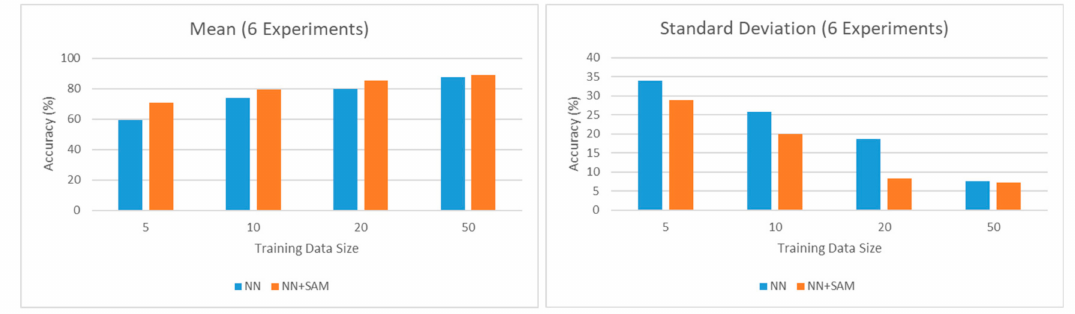
Figure 16. Average and standard deviation of accuracy with the general ANN and proposed algorithm across six